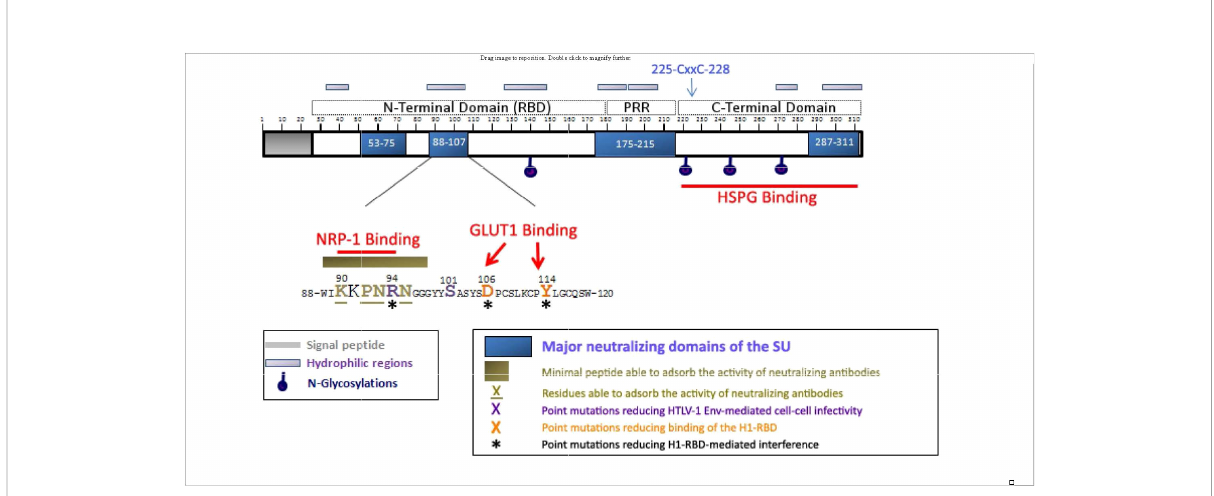
FIGURE 2 Localization of the neutralizing regions and the domains and residues involved in HSPGs, NRP-1, and GLUT-1 binding within the HTLV-1 SU protein. The 90-94 motif identi fi ed as critical for direct NRP-1 binding corresponds to a minimal neutralizing epitope, and contains the R94 residue required for HTLV-1 particle infectivity. R94, as well as D106 and Y114 that mediate binding of the H1-RBD to target cells are required for H1-RBD-mediated receptor interference. The C-terminal domain of the SU contains the determinants for HSPG binding. Published with permission from the author and the journal